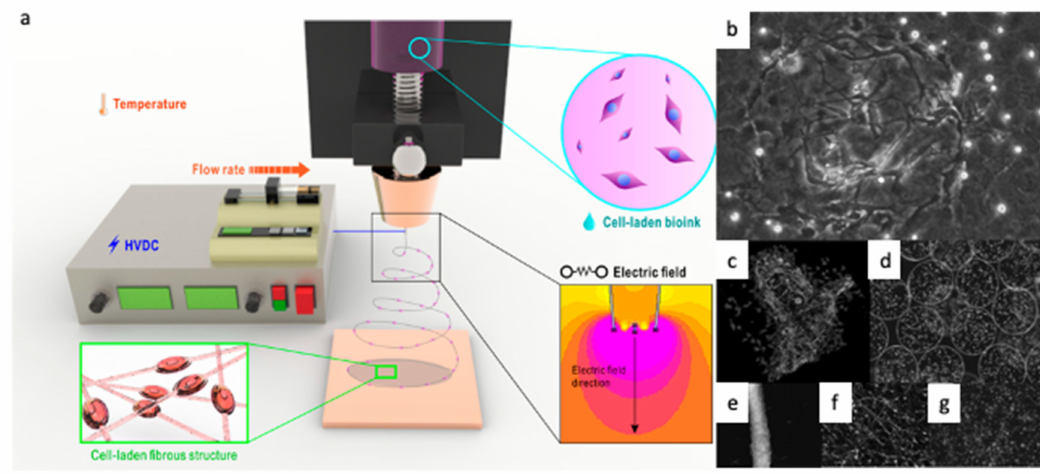
Figure 2. ( a ) Cell-electrospinning process with the basic components. Adapted from [79,91] with permission from MDPI. ( b – d ) Images of living structures fabricated using either BES or ( e – g ) CE. ( b ) Characteristic optical image illustrating a four cell culture system created in three dimensions (the image depicts cellular networks in three dimensions). ( c ) Confocal microscopy image of a three-dimensional culture prepared with the three major cell types of the myocardium (cardiac myocytes, endothelial cells, and fibroblasts). ( d ) Immobilized cells as composite living beads. ( e ) A vessel formed with cells embedded in the individual fibers. ( f , g ) The fiber configurations that could be altered from containing a single cell to a heterogeneous cell population. Adapted from [103] with permission from Wiley